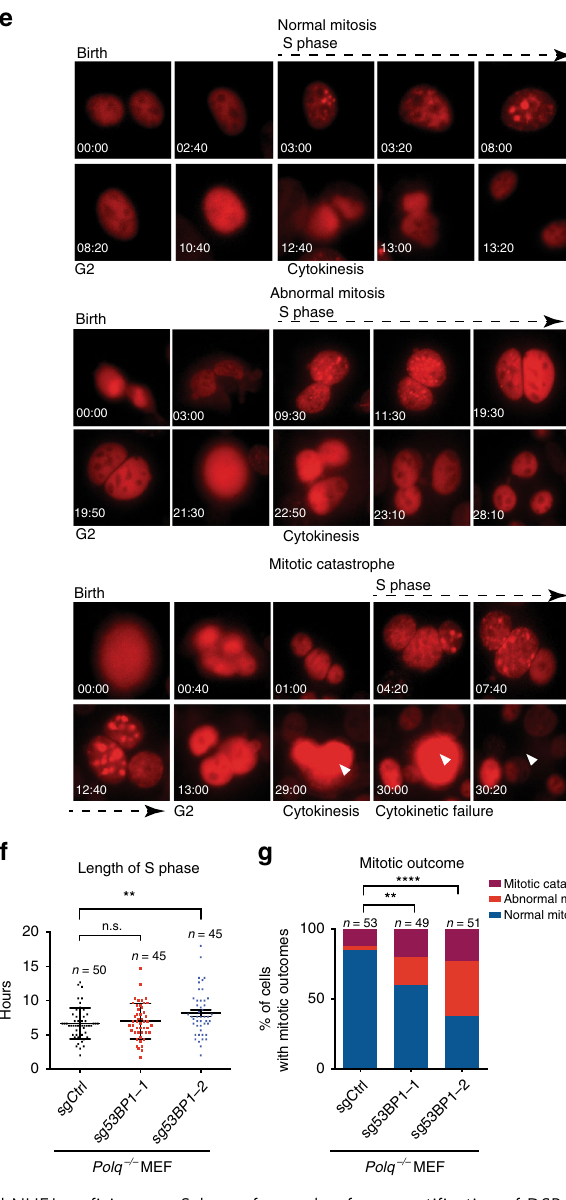
Fig. 2 Synthetic lethality of Polq / 53bp1 double knockout cells despite HR and NHEJ pro fi ciency. a Schema for marker-free quanti fi cation of DSB repair pathway choice at a CRISPR-induced chromosomal break using dPCR. b Quanti fi cation of HR, NHEJ, and TMEJ repair at the Rosa26 locus, relative to WT + sgCtrl. Data shown are the mean ± SEM ( n = 3 biological replicates). Signi fi cance determined using an unpaired, two-tailed t -test (* p < 0.05; ** p < 0.01; **** p < 0.0001). c Diagram of growth competition assay to assess kinetics of synthetic lethality between Polq and 53bp1 . DD-Cas9 is protected from degradation upon exposure to a synthetic ligand (Shield1). Depletion of mVenus-positive cells over time after Shield1 exposure is indicative of sgRNA lethality. d Normalized percentage of mVenus-positive cells over time after Shield1 treatment, measured by fl ow cytometry. The mean fraction of mVenus- positive cells ± SEM ( n = 3) is shown for the various genotypes, normalized to day 0 (no shield). Polq − / − + sg53bp1-1 or -2 ****, p < 0.0001 using two- tailed nonparametric Spearman correlation in GraphPad Prisim v7.04. e – g Time lapse microscopy of PCNA-mCherry to assess cell cycle phase transitions in individual Polq − / − cells 48 h after Shield1 treatment. Cell lines used in this experiment are described in ( c ) after mVenus sorting. e Image descriptions for the three mitotic outcomes. Mitotic catastrophe is a terminal event with cells undergoing nuclear degradation, and abnormal mitosis refers to cytokinesis failure or chromosomal mis-segregation events resulting in abnormal nuclear structure in subsequent daughter cells. f Distribution of S phase lengths in Polq − / − MEFs transduced with sgCtrl, sg53bp1-1, and sg53bp1-2. ** p < 0.01 using a two-tailed t -test. g Analysis of mitotic outcome of individual cells with the indicated genotypes. Abnormal mitosis refers to cytokinetic failure or mis-segregation events resulting in abnormal nuclear structure in subsequent daughter cells. Mitotic catastrophe refers to abnormal mitoses resulting in cell death or disappearance. Signi fi cance determined using a Chi-square test (** p < 0.01 and **** p <